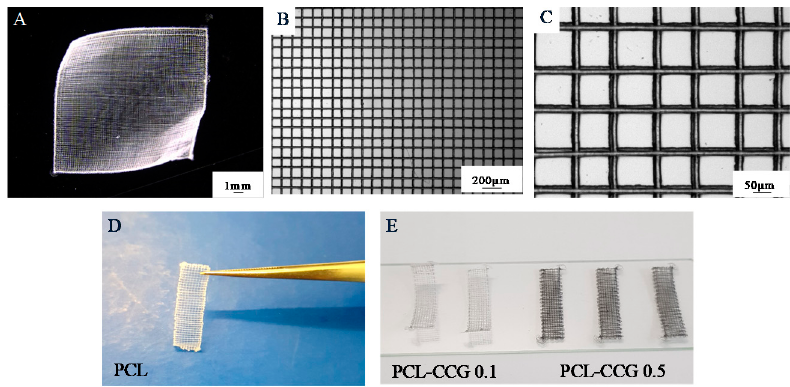
Figure 1. Printed scaffolds of PCL ( A – D ) and scaffolds to mechanical testing ( D – E